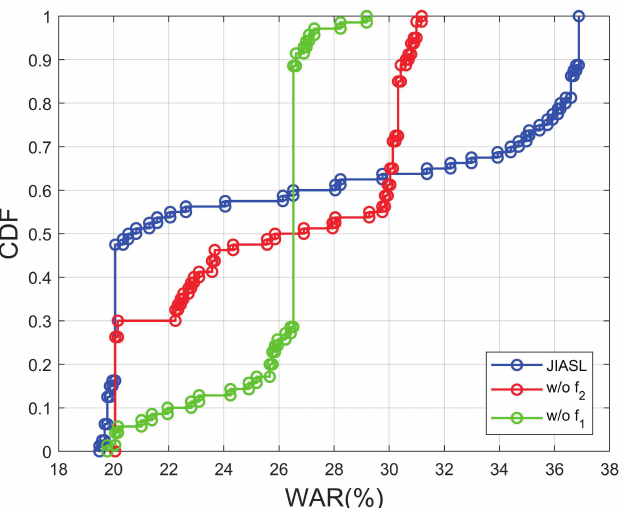
Figure 1. The cumulative distribution function (CDF) with respect to WAR for the cross-corpus SER task of B → E, in which w/o f 2 and w/o f 1 represent the proposed JIASL without the terms f 2 and f 1 ,